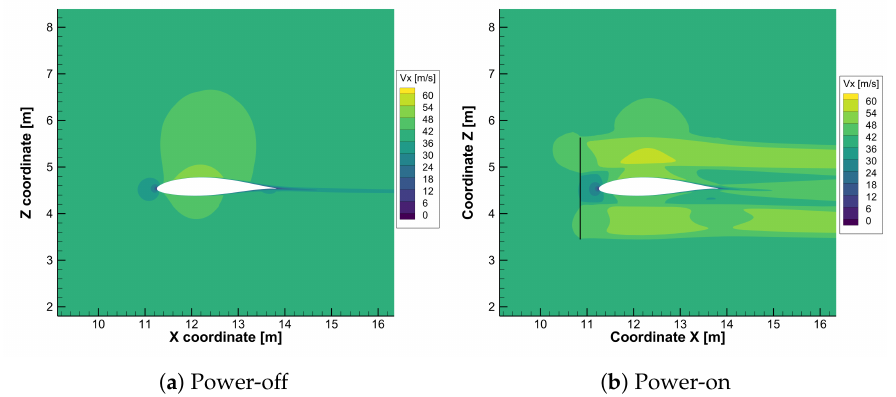
Figure 15. Streamwise velocity component in the mid-plane for α = 0 ◦ . ANSYS-FLUENT